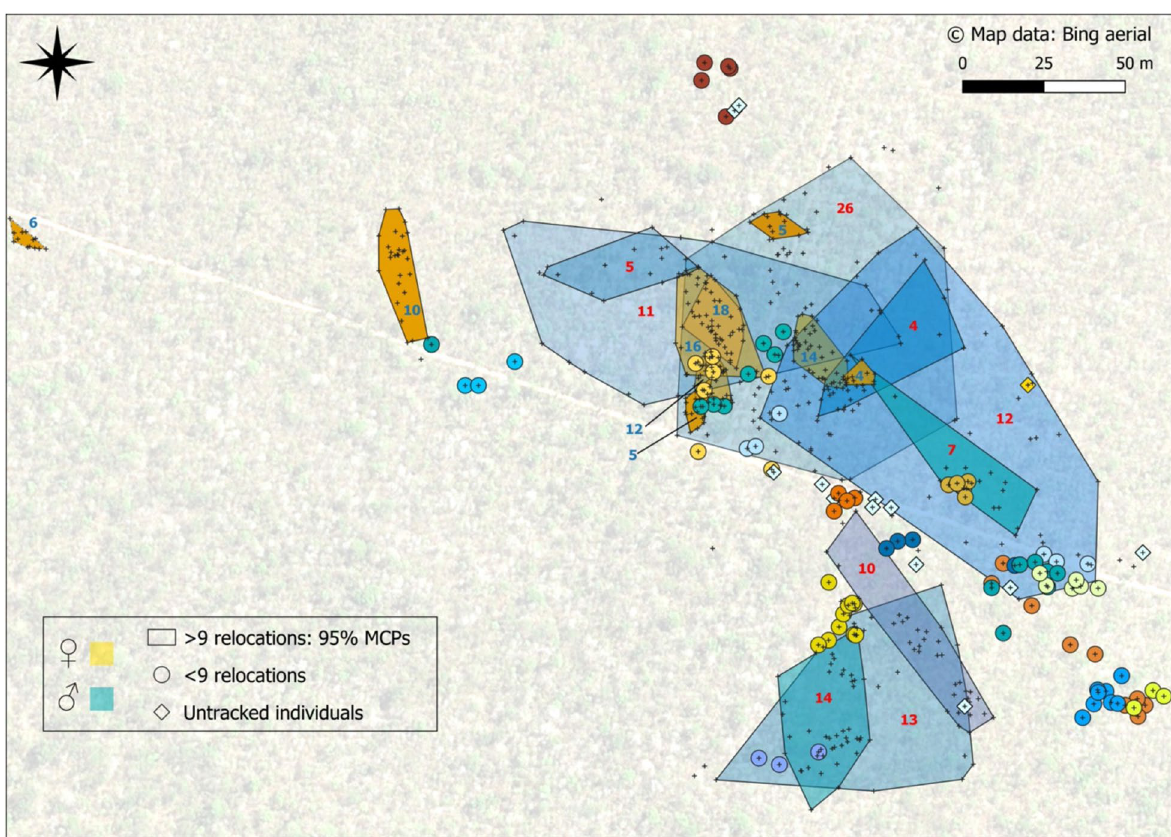
Figure 1. Overview of male (blue) and female (orange) Labord’s chameleons tracked in the study area, showing high local densities and larger occurrence distributions in males. 95% MCPs are shown for all individuals tracked for longer than 3 days, and numbers represent the number of days each individual was tracked. Figure was generated with http:// qgis. osgeo. org, using map data licensed by Microsoft Bing Aerial 2021 (https:// www. micro soft. com/ en- us/ maps/ produ ct/ print-